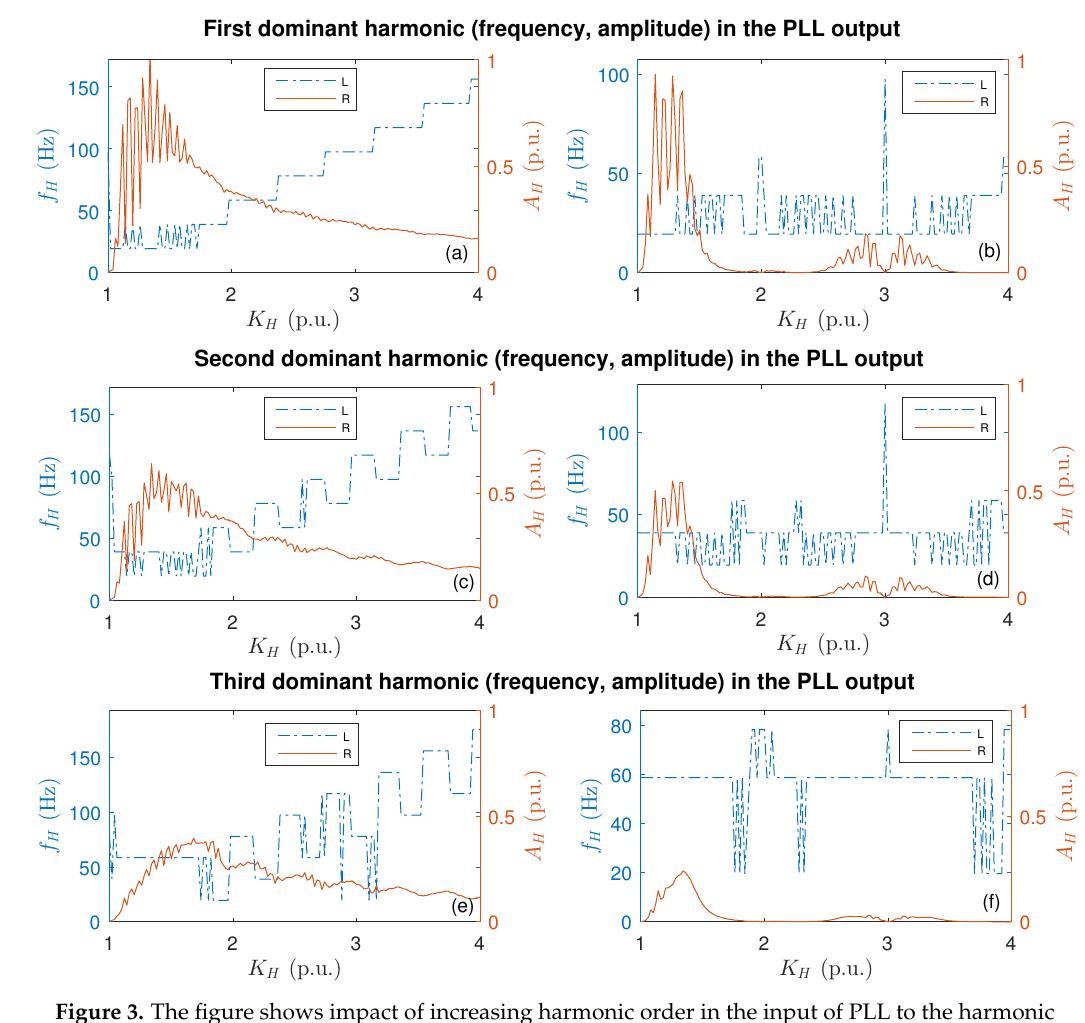
Figure 3. The figure shows impact of increasing harmonic order in the input of PLL to the harmonic contents of frequency estimated at the output. Each sub-figure has on x-axis the harmonic frequency order ( K H ) in per-unit to the nominal frequency of 50 Hz. As the harmonic order is increased, the output harmonic frequency ( f H ) and the amplitude ( A H ) are shown on the y-axes, where the dominant suggests amplitude and (L, R) are referring to left and right axes. The figures are arranged as, without filtering on left-side ( a , c , e ) and considering PLL low-pass filter on the right-side ( b , d , f ), respectively. The f c of PLL is set to 20